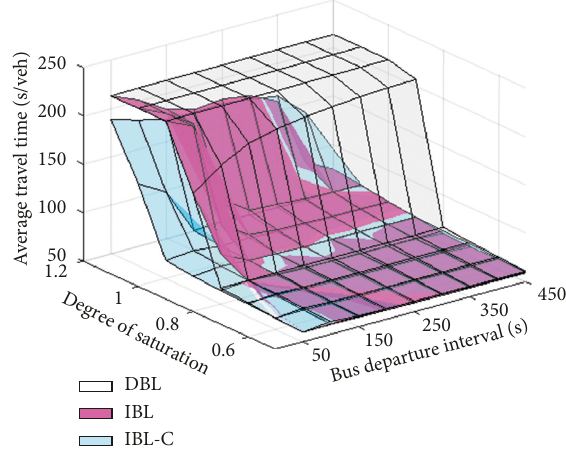
Figure 11: Average travel time of regular vehicles with near-side bus stop.